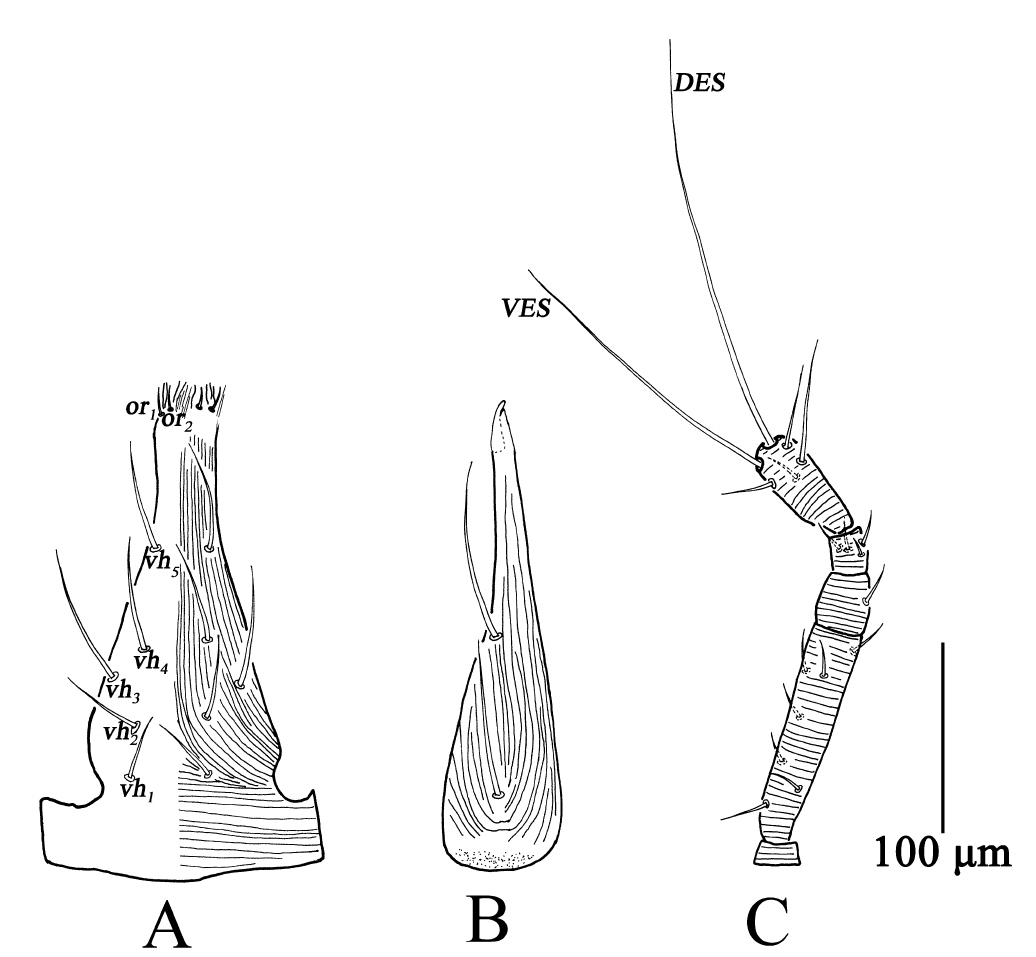
Figure 4. Bdella muscorum , tritonymph: ( A ) Subcapitulum; ( B ) Chelicera; ( C ) Palp.